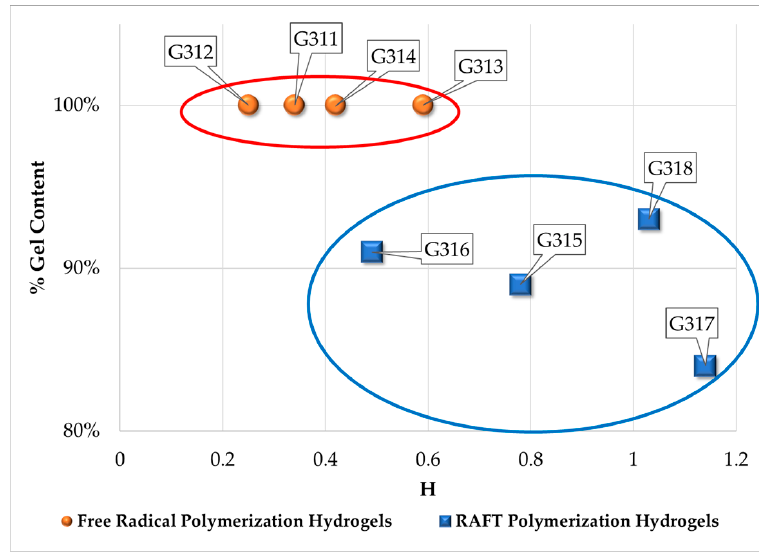
Figure 6. Correlation between gel content and the polymer network homogeneity parameter ( H ).